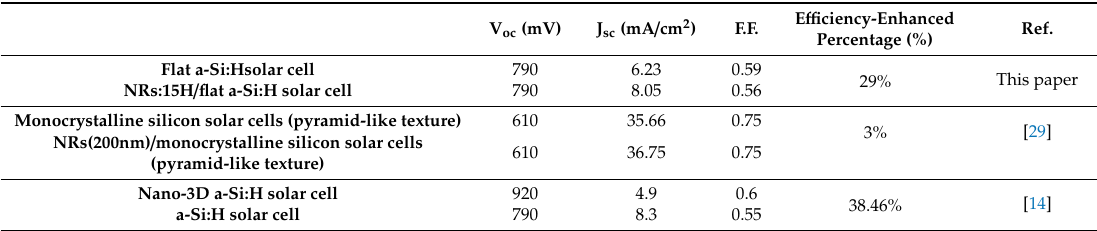
Table 1. The results for monocrystalline and amorphous silicon solar cells with zinc oxide nanorods in this paper and other